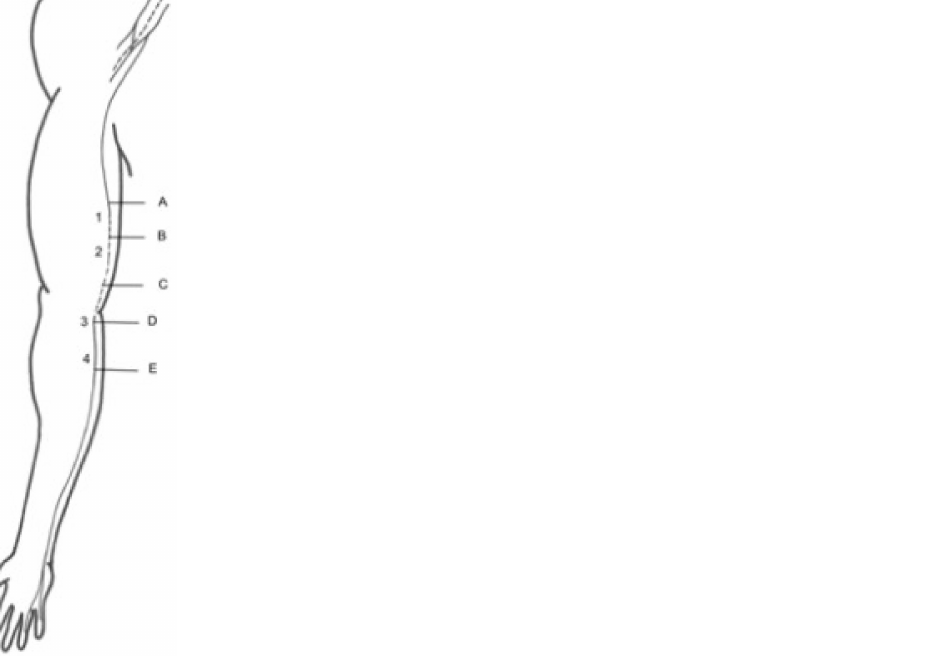
Figure 1. Numbers from 1 to 4 indicate the four specific locations of possible ulnar nerve entrapment to evaluate. Letters from A to E correspond to the anatomical landmarks where the nerve’s diameter and perimeter measurements were